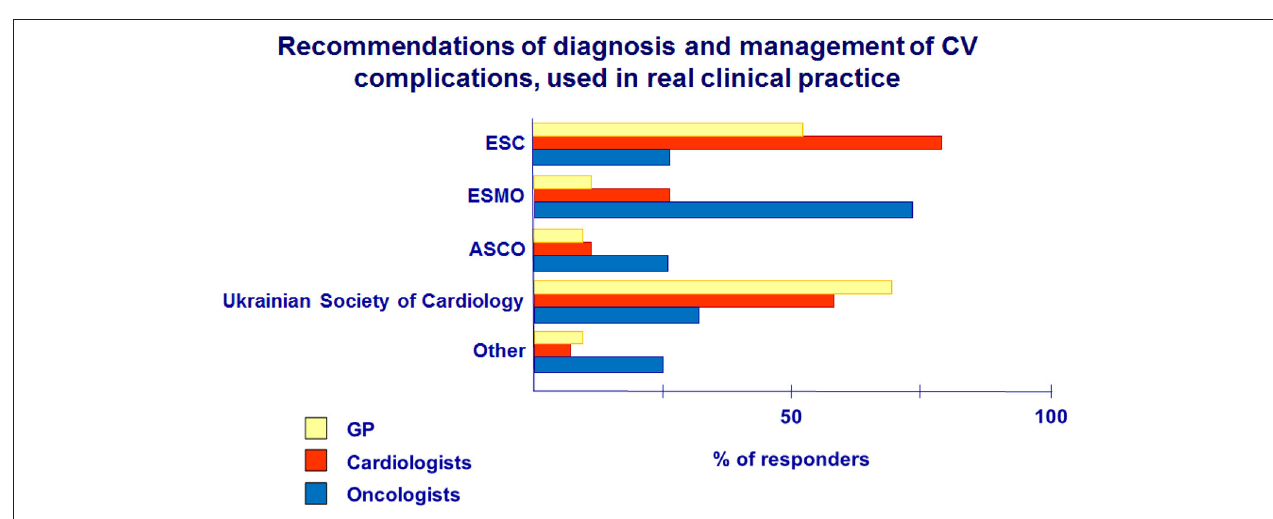
FIGURE 7 | Recommendations for diagnosis and management of CV complications of cancer treatment, used in real clinical